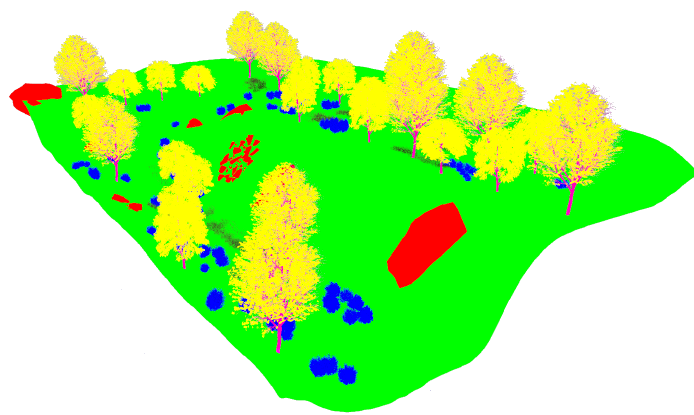
Figure 16. The plain visual model of the hillside environment.